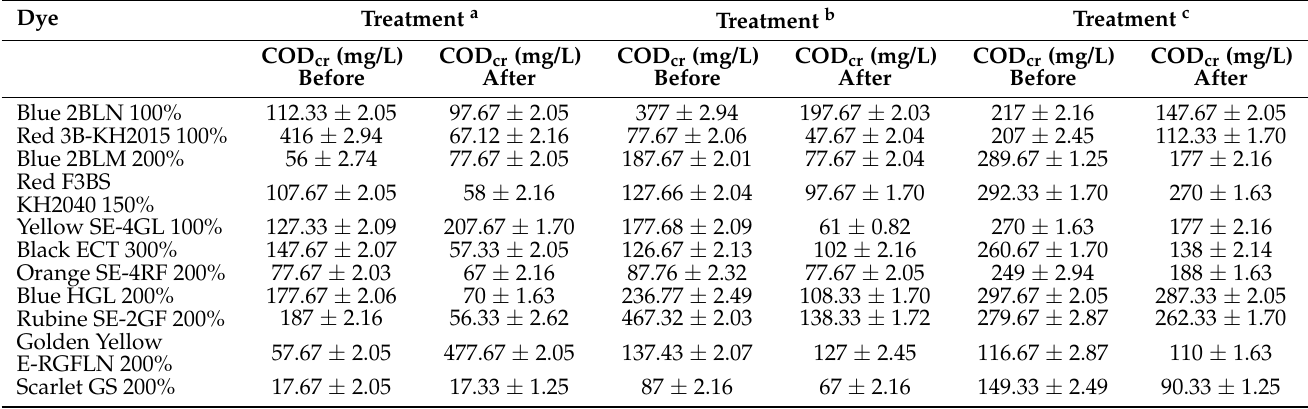
Table 3. Variation in COD (mg/L) of dye solution before and after AS oxygen uptake experiment. The initial dye concentration was 50 mg/L, which was treated with laccase or laccase + HBT. Treatments a, b, and c represent un-decolorized dye solution with heat-deactivated laccase followed by AS, decolorized dye solution with only laccase followed by AS, and decolorized dye solution with laccase + HBT followed by AS,